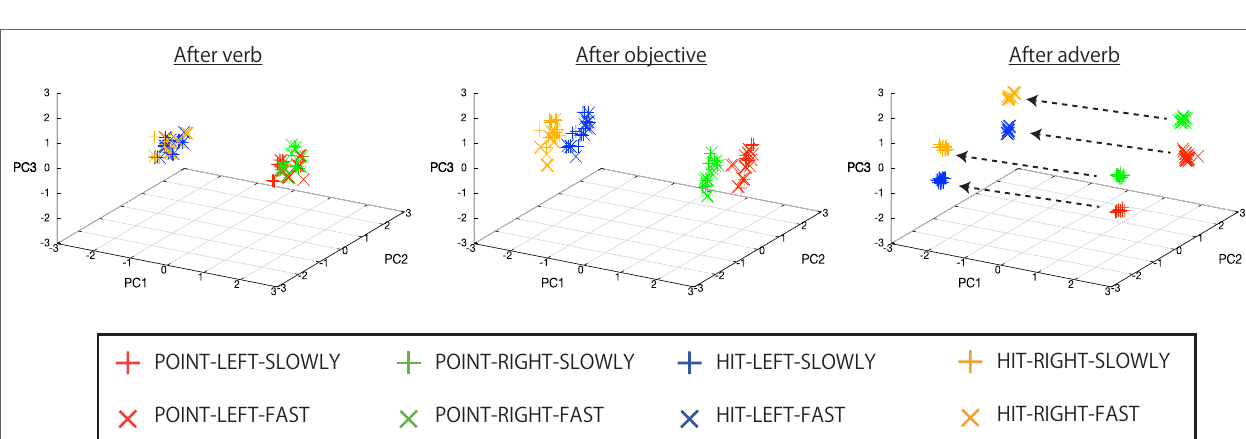
from the 9-word inputs that were orthogonal to each other through a series of branching dynamics. Last, it was confirmed that the robot can wait stably for instruc- tions in its initial posture, thanks to a stable characteristic of the initial point. This characteristic was evaluated as follows. After looped input of joint angles without any instruction inputs.